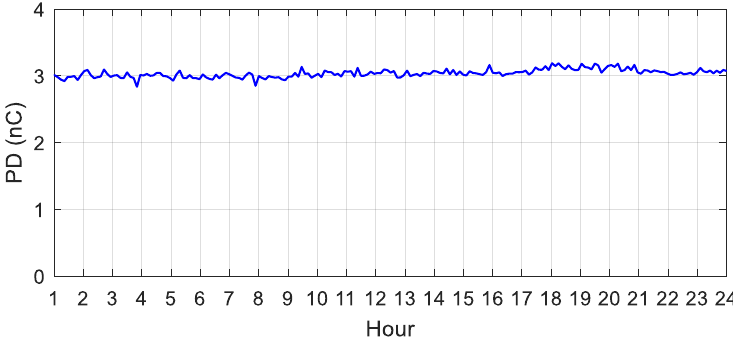
Figure 25. Apparent charge monitored over a day for a defect-free transformer.